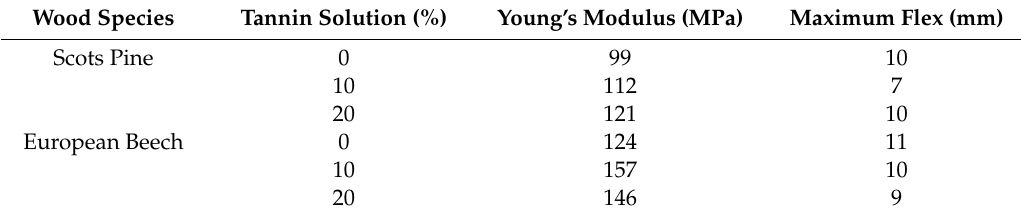
Table 9. Bending data [84].